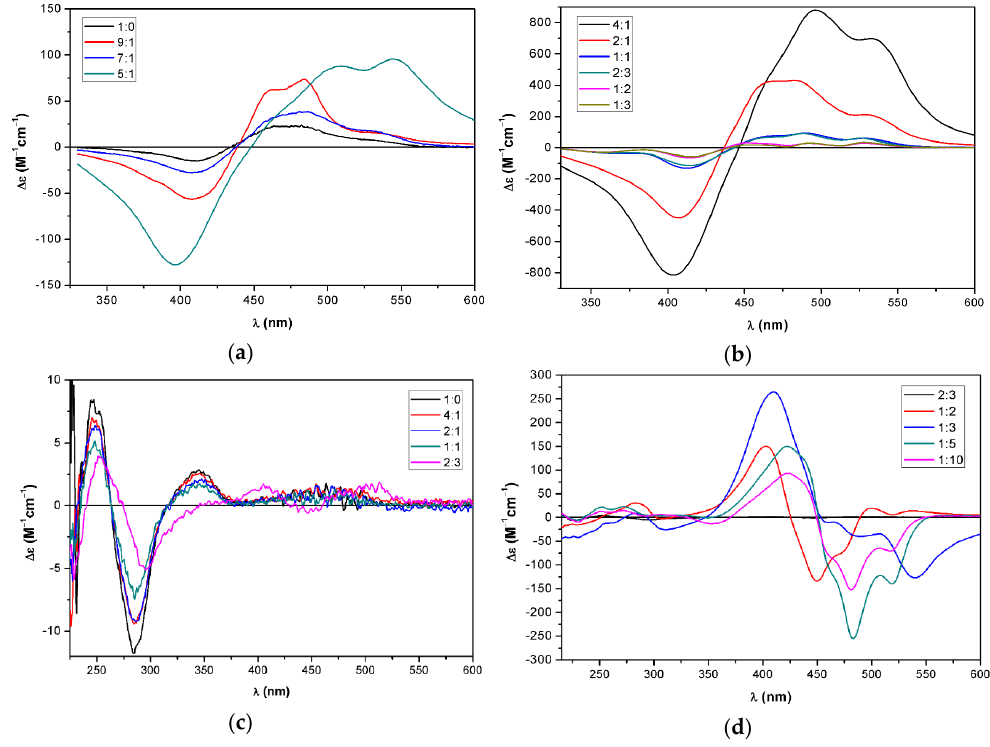
Figure 5. ECD spectra of bistriazole chrysin–zeaxanthin conjugate 22 in ( a ) acetone / water 1:0–5:1; ( b ) acetone / water 4:1–1:3 ( c ) THF / water 1:0–2:3. ( d ) THF / water